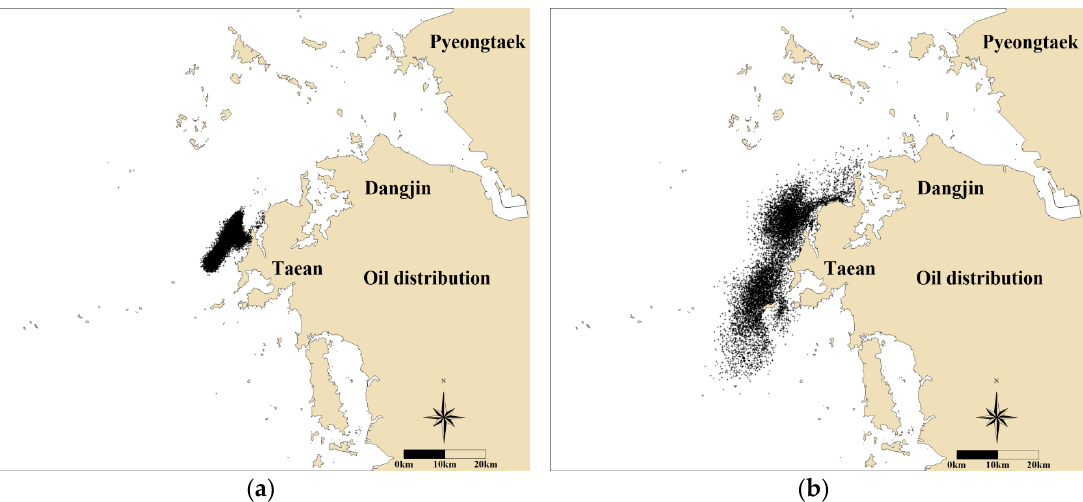
Figure 18. Oil distribution considering tidal current, wind, and wave conditions: at 8 p.m., on 7 December 2007, ( a ) 13 h after the accident; ( b ) at 11 a.m., on 11 December 2007.